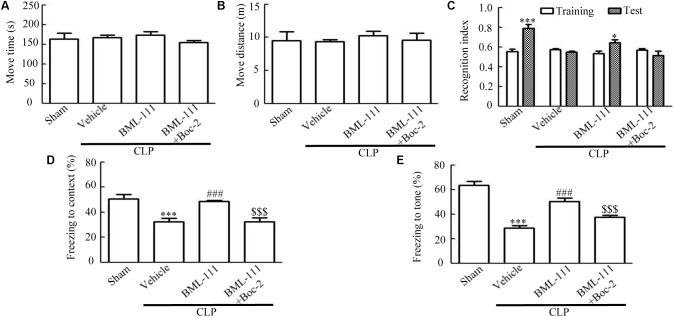
BML-111 treatment reduces cognitive dysfunction in mice with sepsis. (A,B) The move time and distance in the open-field test did not differ among the four groups. (C) Sepsis did not result in the recognition index for the new object differing from that for the familiar one, whereas that for the new object in the sham group differed significantly from that for the familiar one. BML-111 treatment reversed the decrease in the recognition index in the CLP mice, and Boc-2 inhibited the effects of BML-111. (D,E) The freezing times in the contextual and tone-conditioning tasks were significantly decreased in the CLP + vehicle group compared with the sham group. BML-111 treatment reversed this decrease, and Boc-2 suppressed the effects of BML-111. Data were shown as the means ± SEM (n = 10 surviving mice per group). ∗P < 0.05, ∗∗∗P < 0.001 represent Test vs. Training in C. ∗∗∗P < 0.001 represents CLP + Vehicle vs. Sham, ###P < 0.001 represents CLP + BML-111 vs. CLP + Vehicle, $$$P < 0.001 represents CLP + BML-111 + Boc-2 vs. CLP + BML-111 in (D,E).